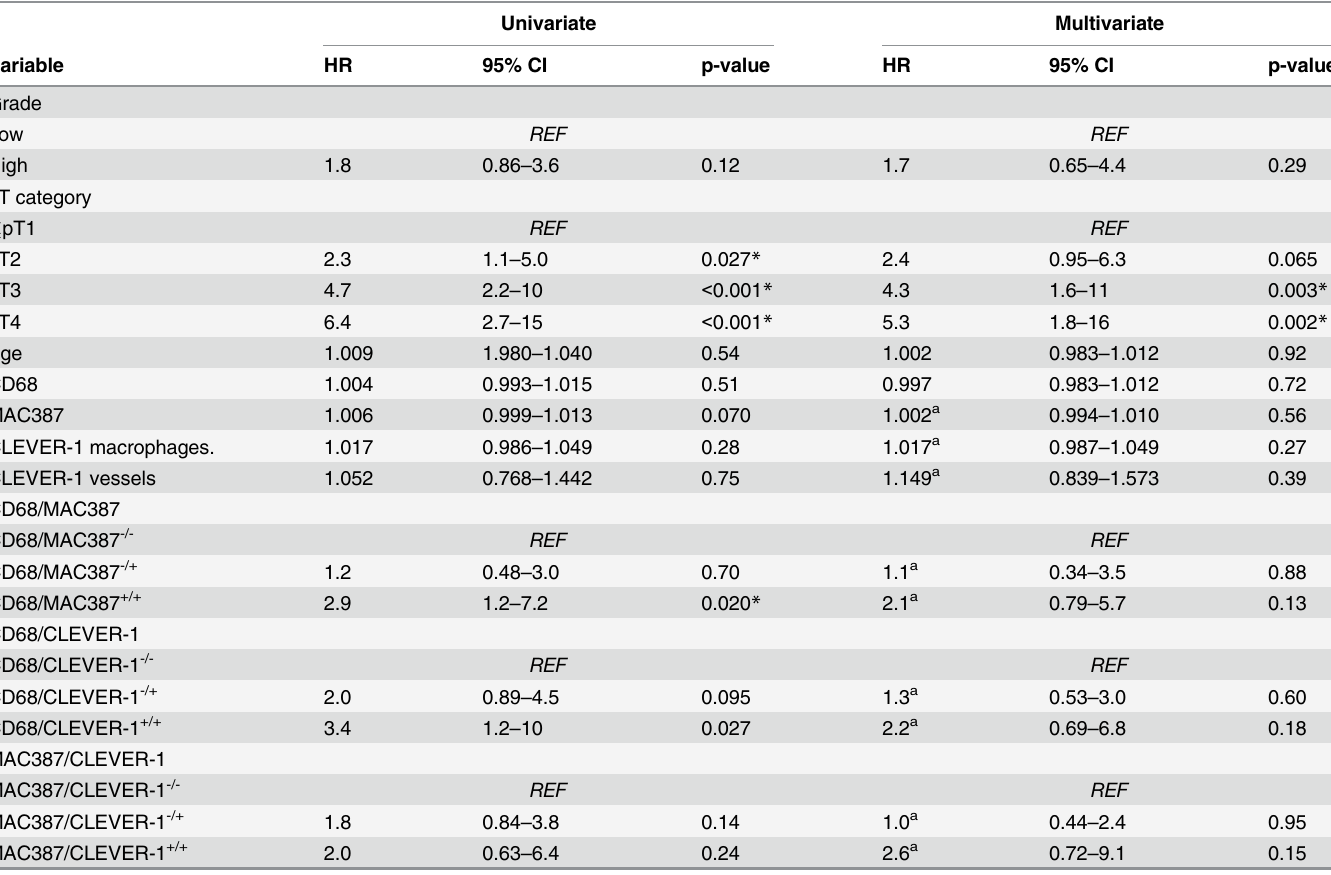
Table 4. Univariate and multivariate Cox proportional hazards regression analysis of factors affecting OS in the RC